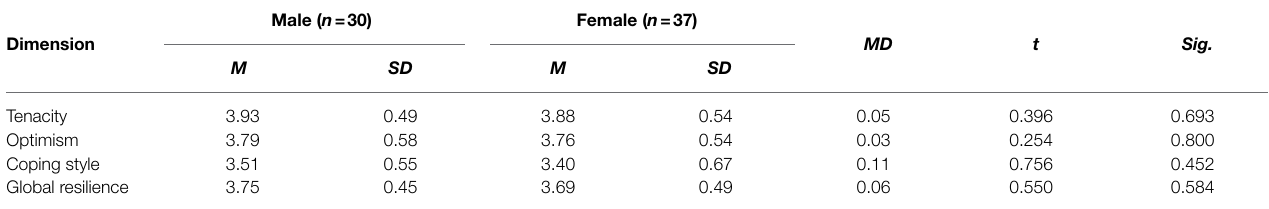
Male ( n = 30) Female ( n = 37)